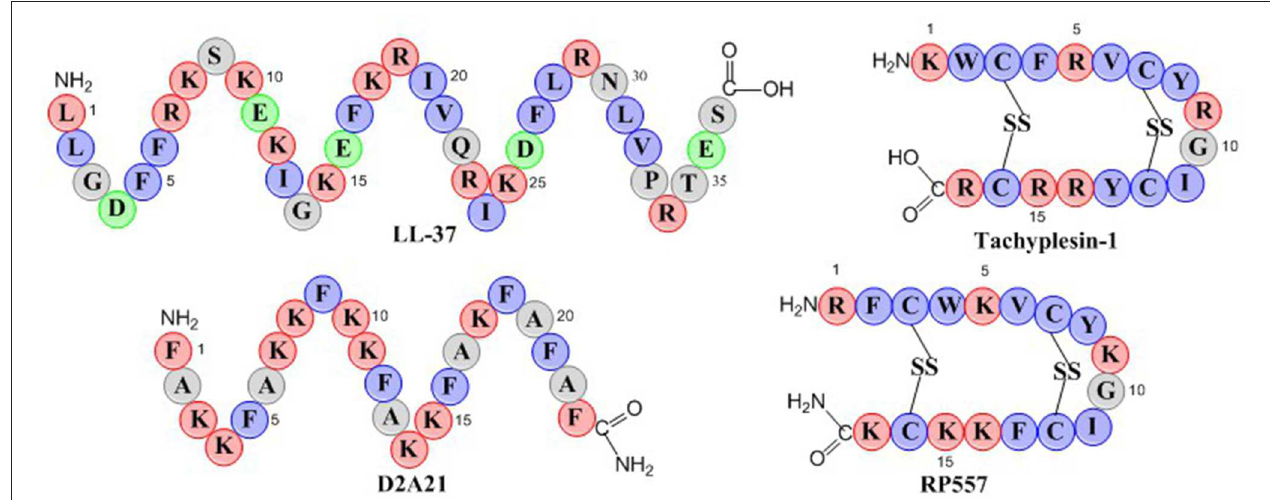
FIGURE 1 | Schematic representation of the endogenous AMPs, LL-37 and Tachyplesin 1 and the dAMPs, D2A21 and RP557. Hydrophobic residues are in blue, while those residues with a net positive charge are in red and those with a negative charge are in green.